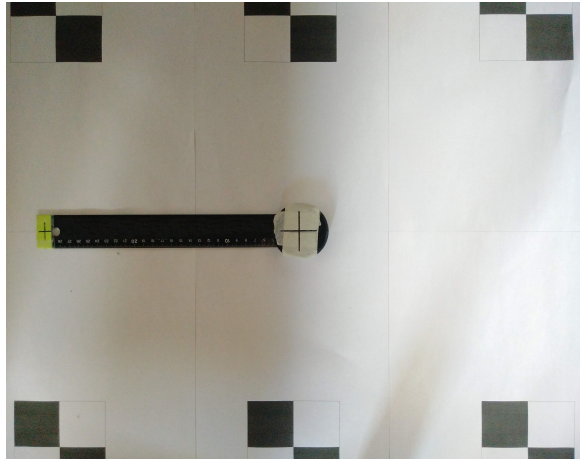
Figure 11. Photogrammetry-based method for yaw axis sensor validation.